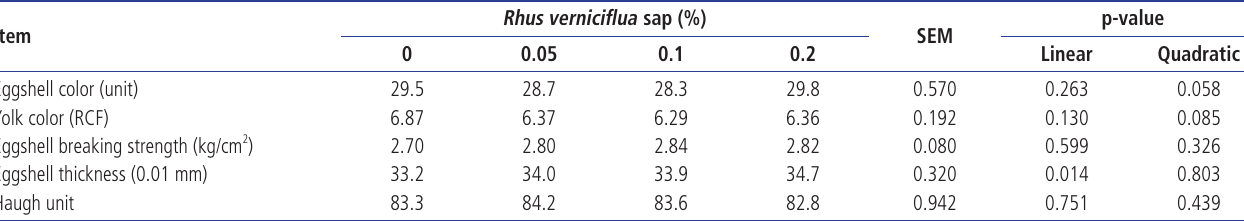
Table 3. Effect of dietary detoxified Rhus verniciflua sap on egg qualities in laying hens